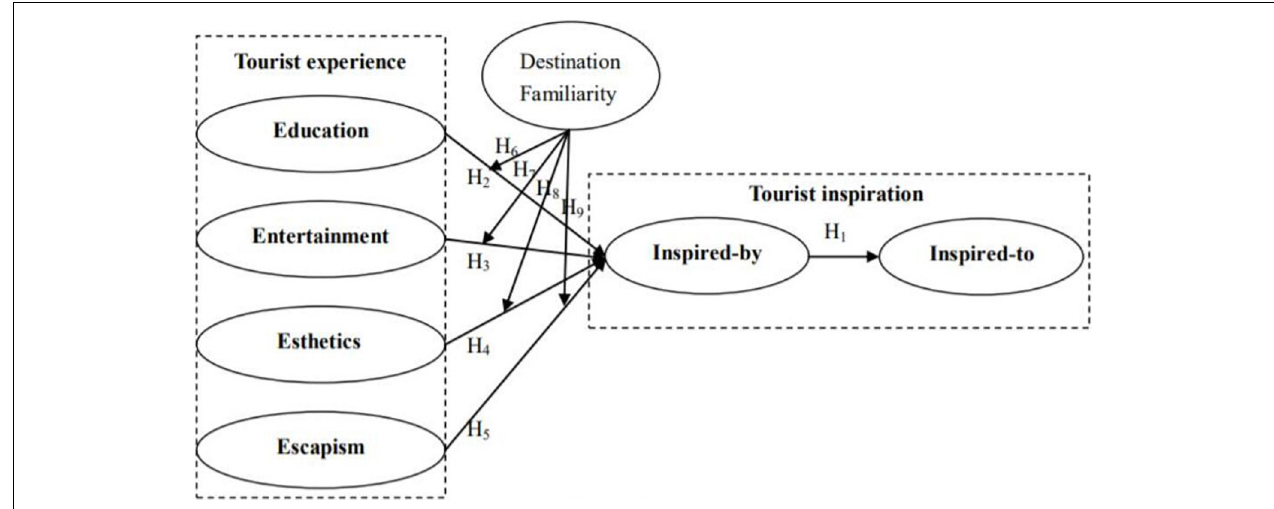
FIGURE 1 | Conceptual